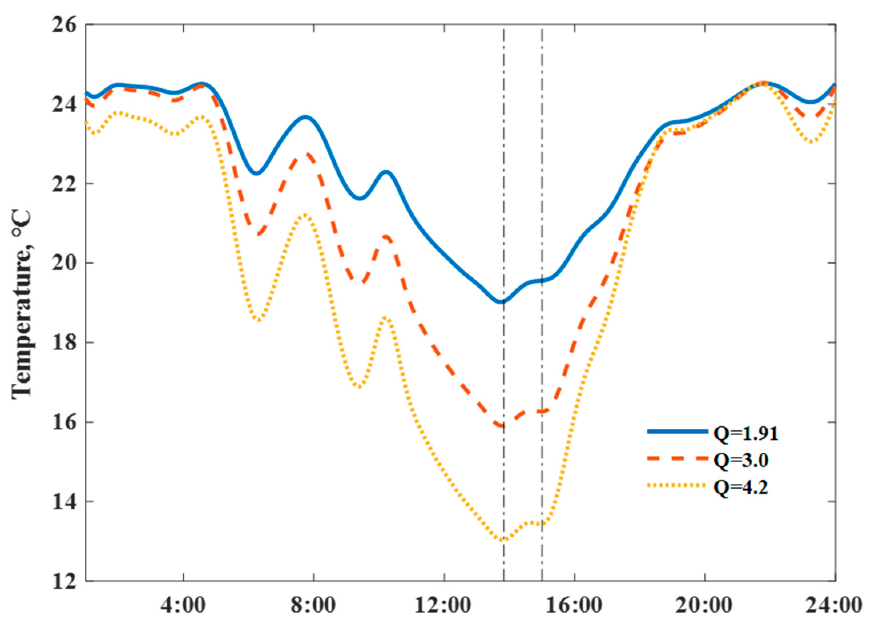
Figure 16. Simulated preheat response behaviors of house with different heat loss coefficient val- ues.